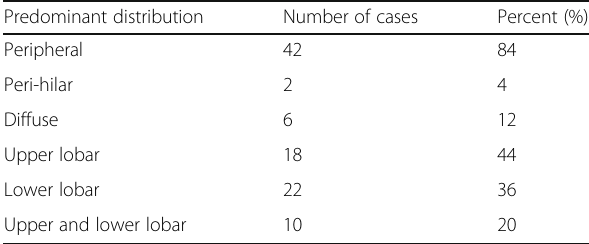
Table 3 Predominant